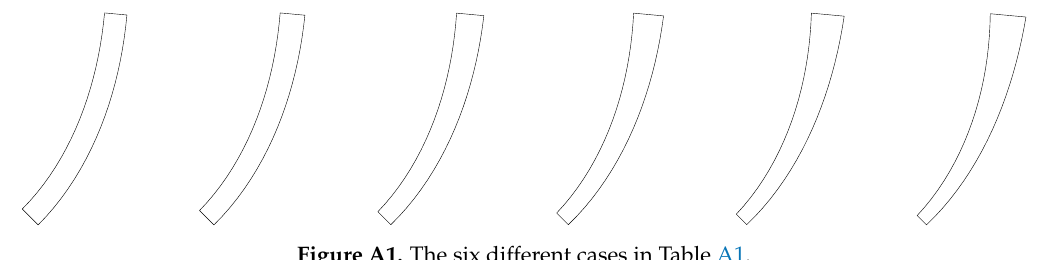
Figure A1. The six different cases in Table A1.